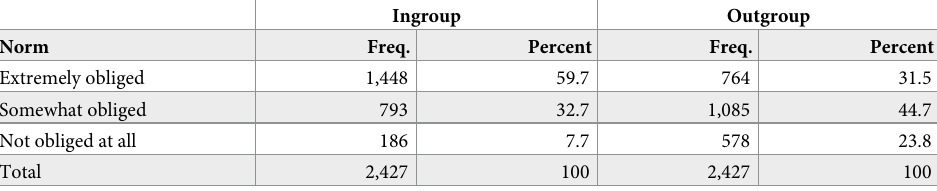
Table 2. Ingroup and outgroup reciprocity norm distribution.